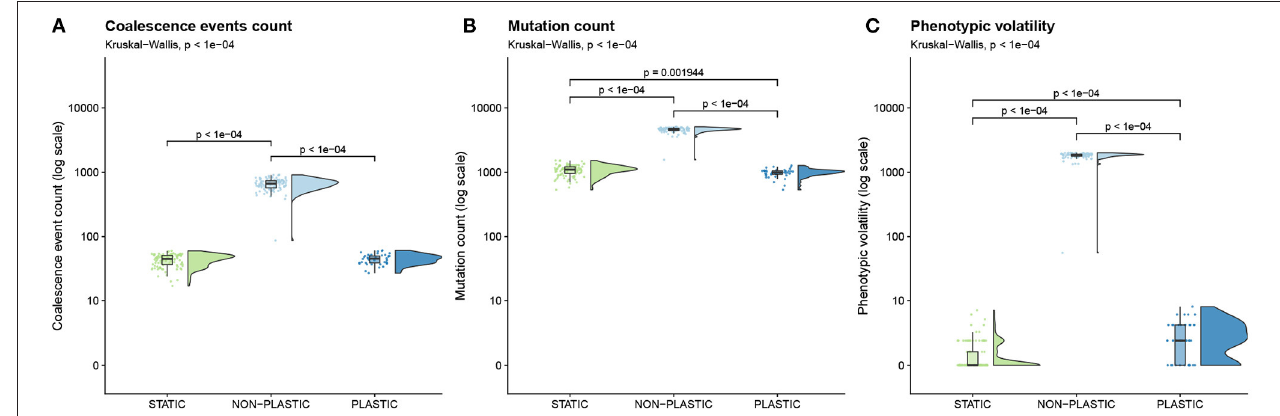
FIGURE 3 | Magnitude of evolutionary change. Raincloud plots (Allen et al., 2019) of (A) coalescence event count, (B) mutation count, and (C) phenotypic volatility. See Table 1 for descriptions of each metric. Each plot is annotated with statistically significant comparisons (Bonferroni-corrected pairwise Wilcoxon rank-sum tests). Note that adaptive phenotypic plasticity evolved in 42 of 100 replicates from the PLASTIC treatment during phase one of this experiment; we used this more limited group to found 42 phase-two PLASTIC replicates from which we report these PLASTIC data.